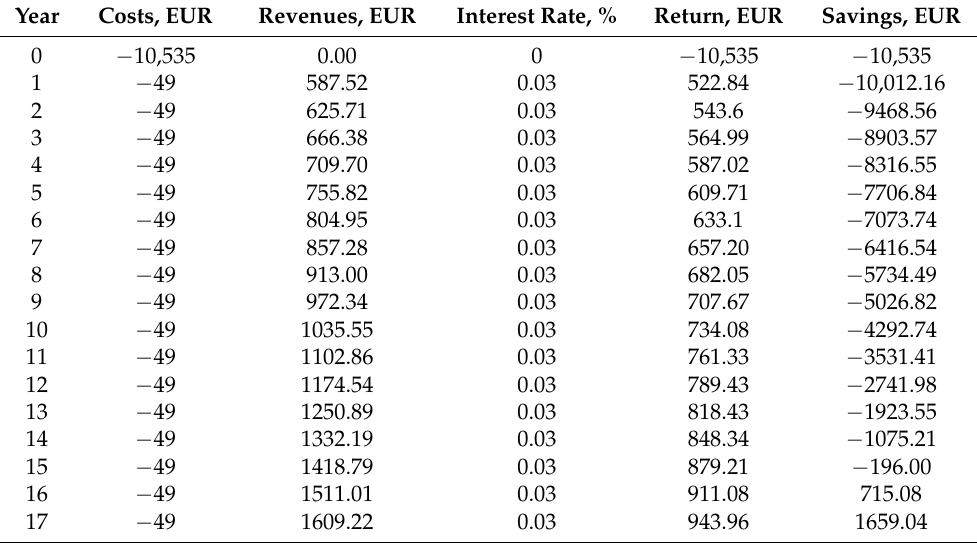
Table 5. An economic evaluation of the investment into the solar